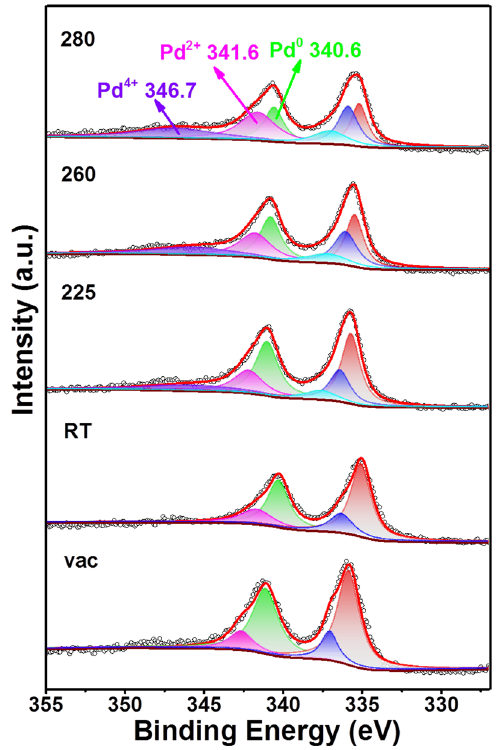
Fig. 6 Pd speciation followed by the in situ NAP-XPS. Pd 3d core-line spectra as a function of reaction conditions for Pd@IM-S-1 at different temperature (from room temperature to 280 °C). The total pressure in